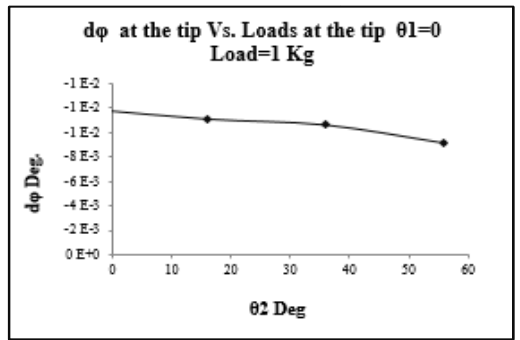
Fig. 10. d ϕ Vs. θ 2 at θ 1=0 Deg. link